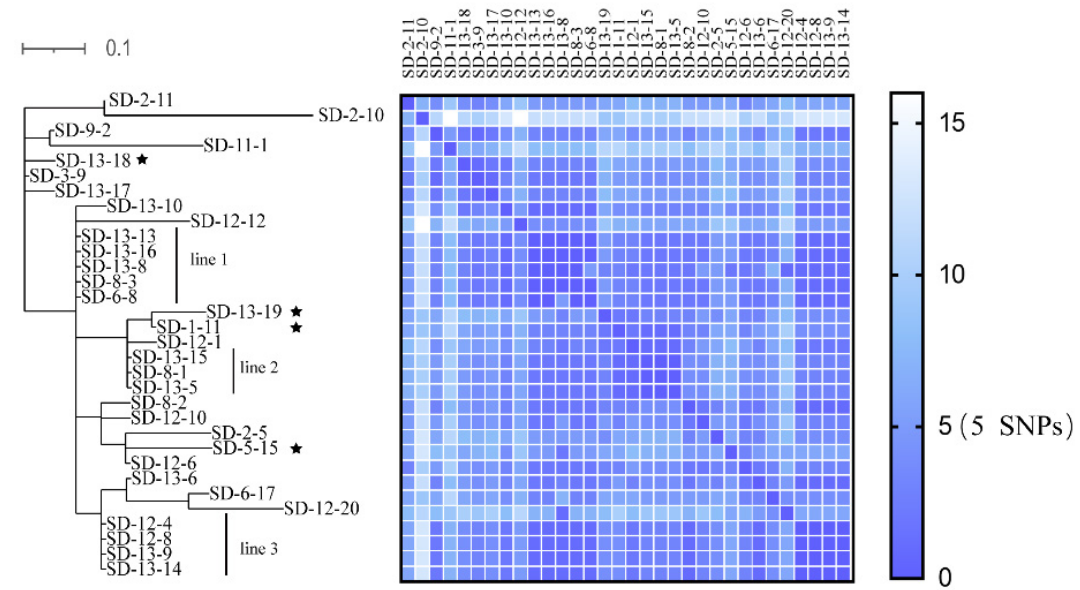
Figure 2. Molecular Phylogenetic analysis by Maximum Likelihood method. Phylogenies were inferred from Single-nucleotide polymorphisms (SNPs) and pairwise SNP distances (0–16 SNPs) are shown using a heat map. The tree is drawn to scale (0.1), with branch lengths measured by the number of substitutions per site. The analysis involved 32 nucleotide